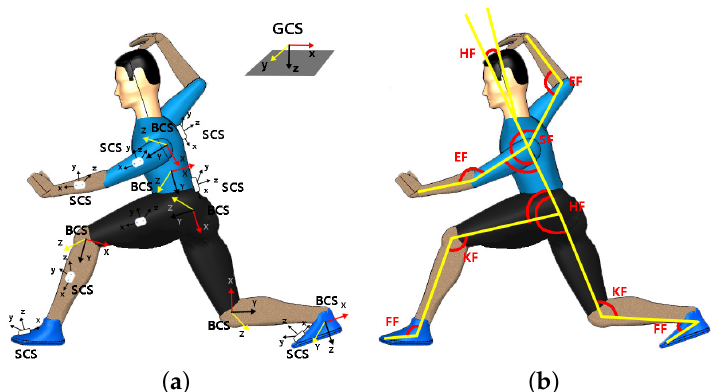
Figure 4. The definition of coordinate system and the limb flexion joint angle. ( a ) the three coordinate systems in self-made inertial motion tracking system. ( b ) the joint angle definition for the athlete